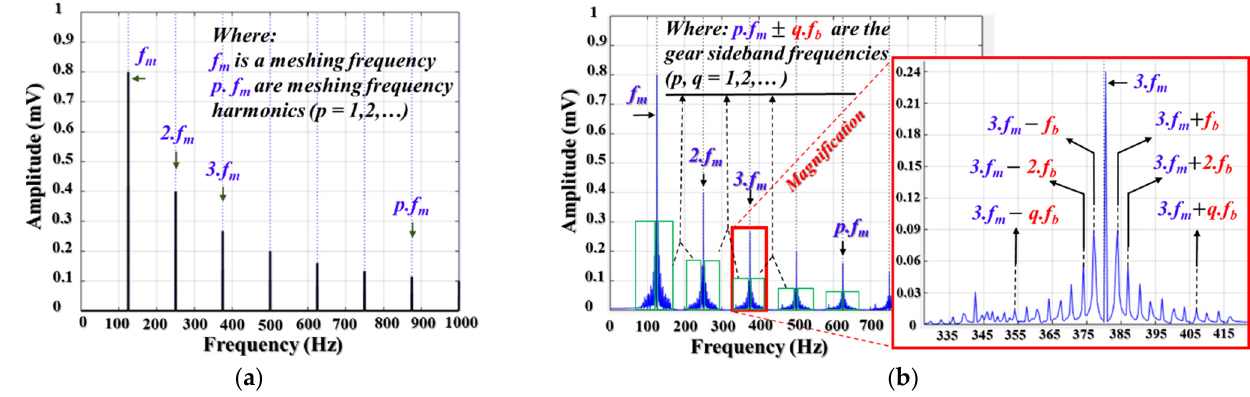
Figure 1. The frequency spectrum of a gearbox ( a ) under normal conditions and ( b ) under defective conditions.